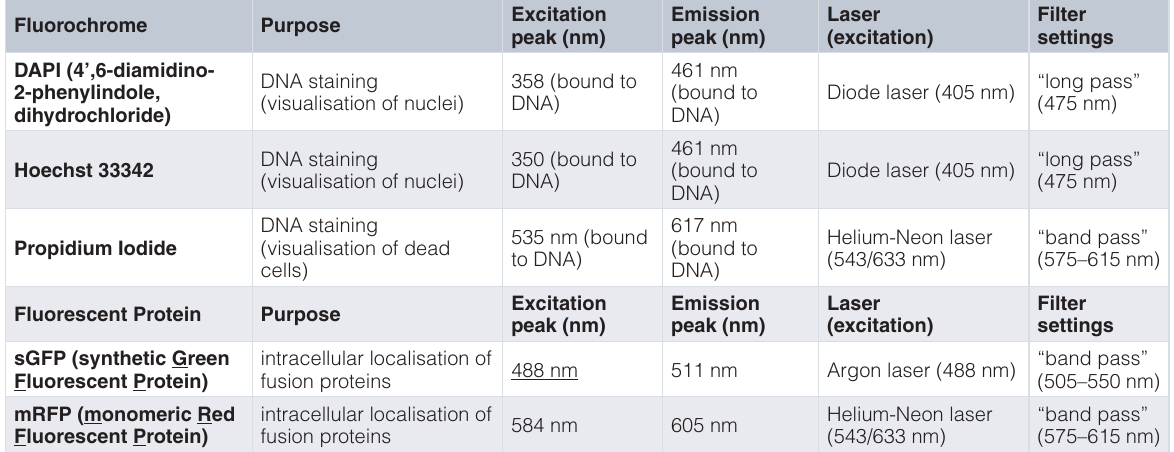
Table 1. Properties of the fluorochromes and fluorescent proteins used in this work.